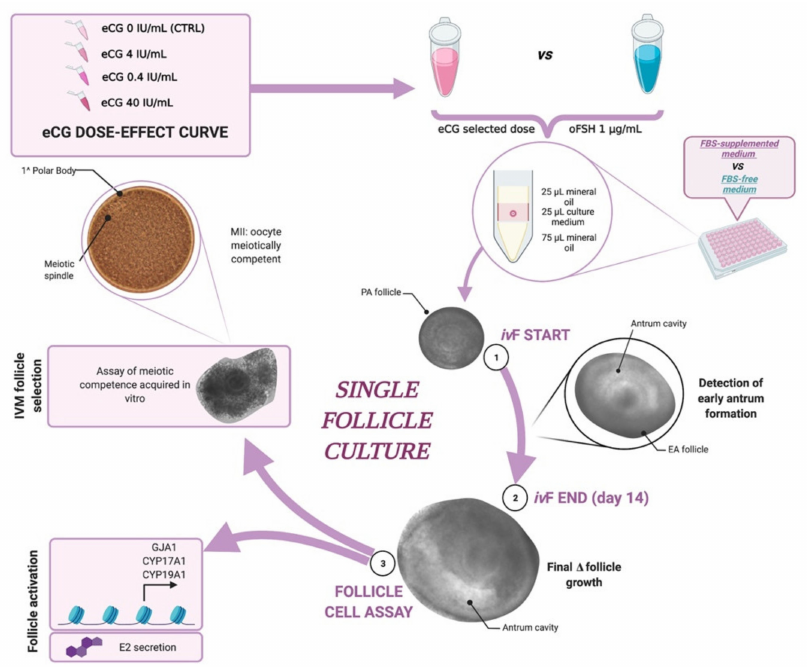
Figure 10. Flow chart of the experimental procedure adopted for culturing PA follicles in vitro. Figure created with BioRender. Available online: https://biorender.com/ (accessed on 15 November 2021).